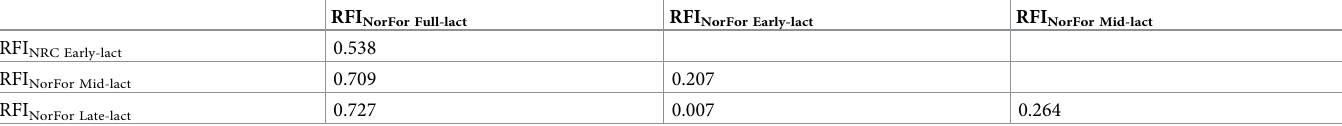
Table 6. Pearson correlation matrix for residual feed intake calculated using the NorFor (2011) equation (RFI NorFor ), estimated using data collected at different stages of the lactation and for the full lactation (n = 36).